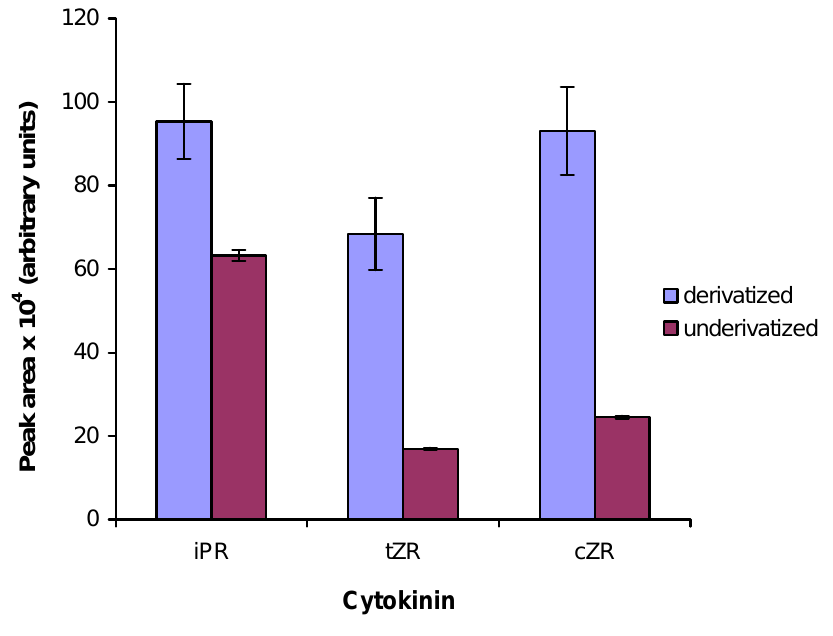
Figure 5. Comparison of ESI-MS response. 10 pmol of derivatized and underivatized cytokinin standards were analyzed using UPLC-MS/MS. Peak areas (arbitrary units) of the first isotopomer are compared. Error bars indicate the standard deviation (n = 4).